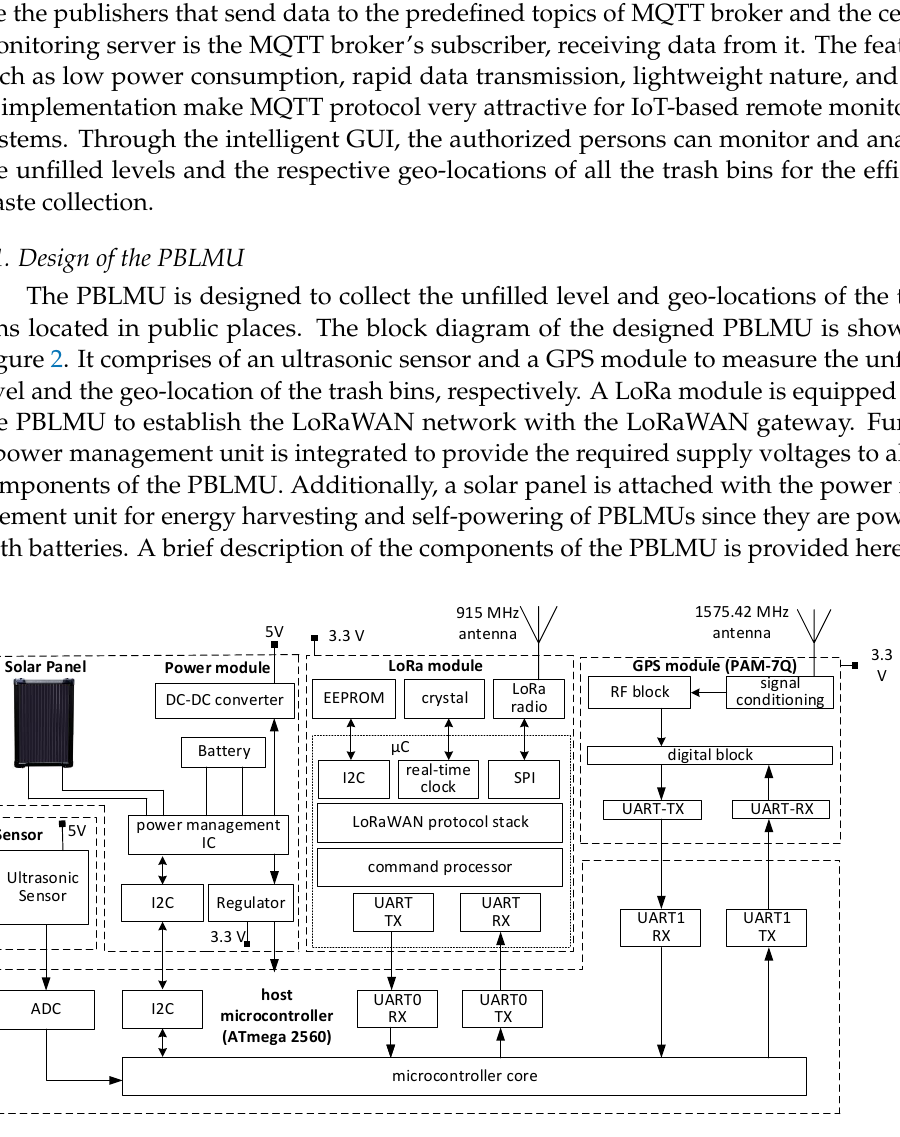
Figure 2. Block diagram of the Public Bin Level Monitoring Unit